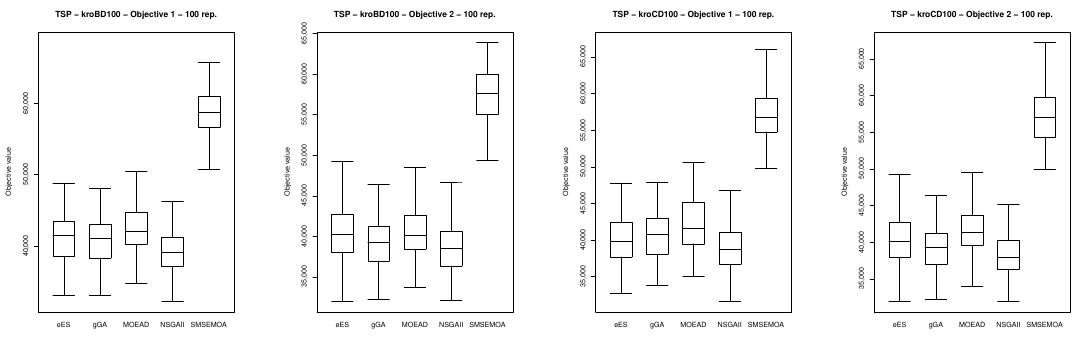
Figure 6. Boxplots showing the results for the TSP achieved by the different single-objective and multi-objective approaches at the end of 100 repetitions of the runs. Some instances were omitted because of space restrictions. However, all graphics can be found in the repository associated with this